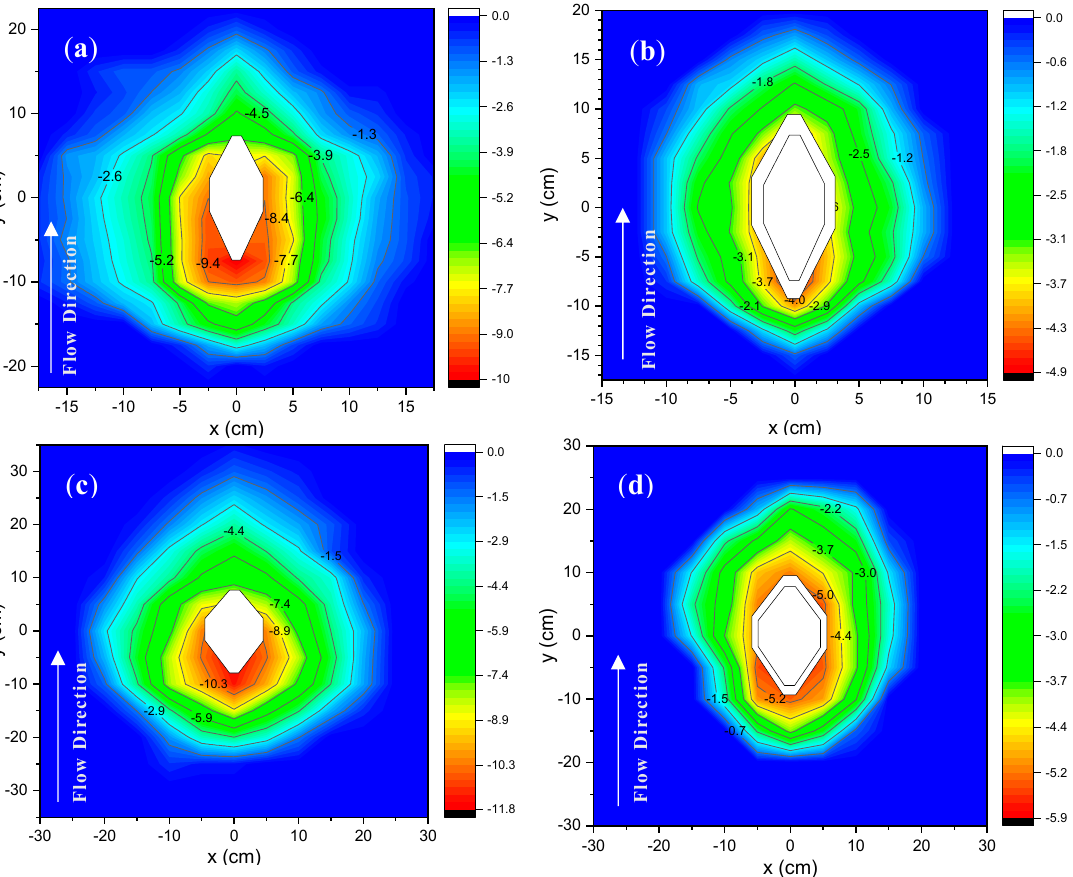
Figure 12. Equilibrium scour hole profile with different pier sizes around ( a ) and ( c ) unprotected octagonal piers with D p = 5 and 10 cm, respectively; ( b ) and ( d ) protected octagonal pier with O-Ca-H modifications with D p = 5 and 10 cm, respectively; on the same bed material ( d 50 = 0.71 mm).